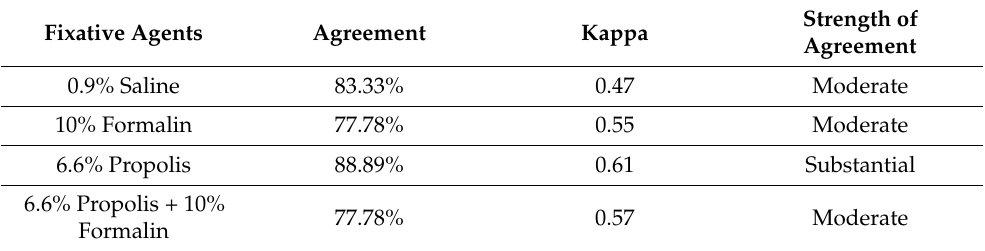
Table 2. Kappa statistics for inter-oral pathologists’